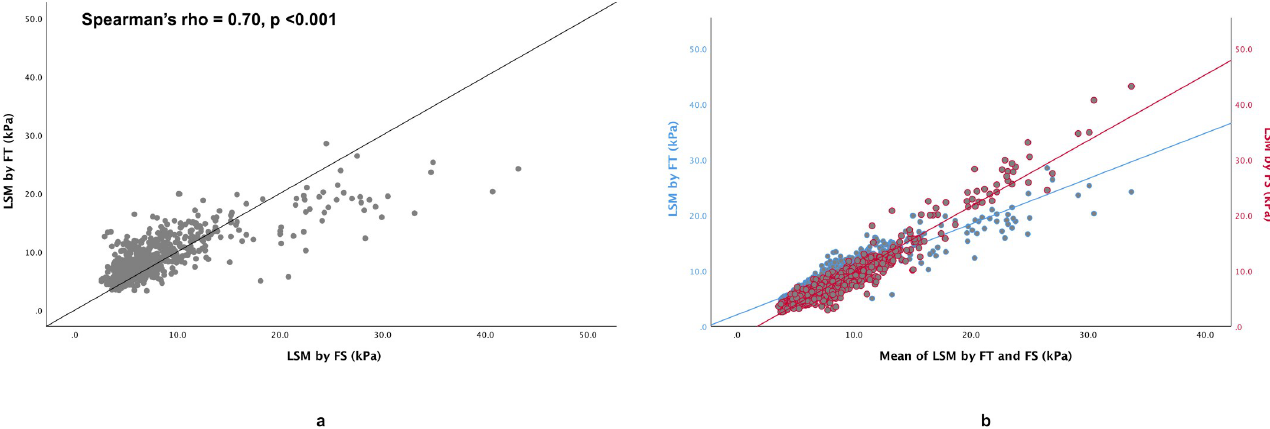
Fig 3. Scatter plots for ( a ) liver stiffness measurements (LSM) obtained using FibroTouch (FT) vs Fibroscan (FS), and ( b ) LSM obtained using FT and FS vs mean of LSM obtained using FT and FS.